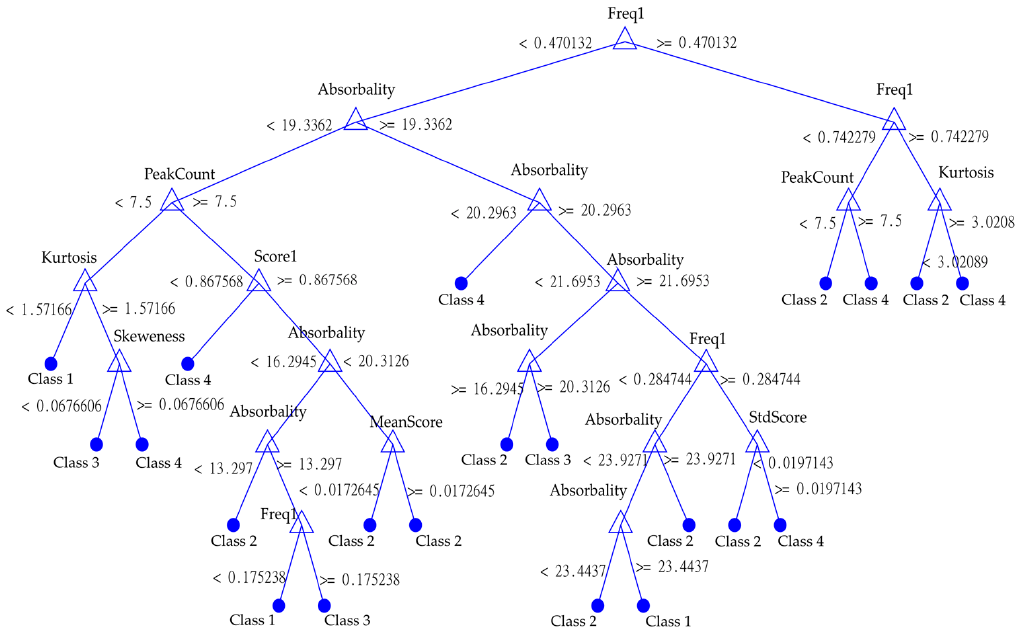
Figure 20. Example of the designed model’s classification tree with parameters, conditions and resulting classes.